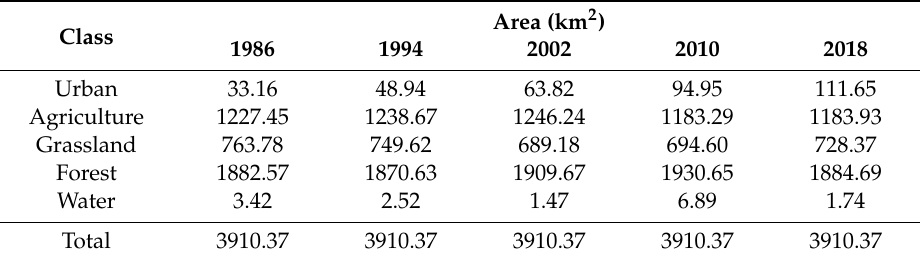
Table 7. LULC in the Alto Atoyac sub-basin for five